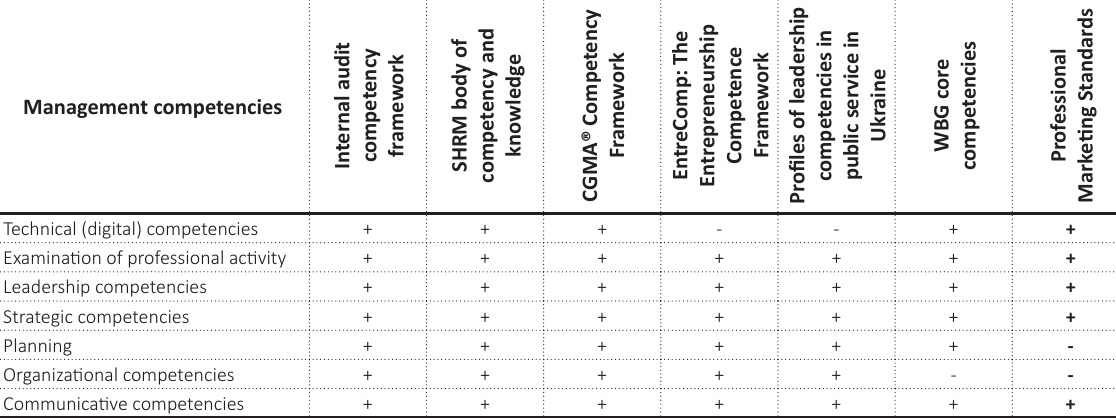
Table A2. Analysis of managerial competencies available in Standards by fields of knowledge 07 “Management and administration” and 28 “Public management and